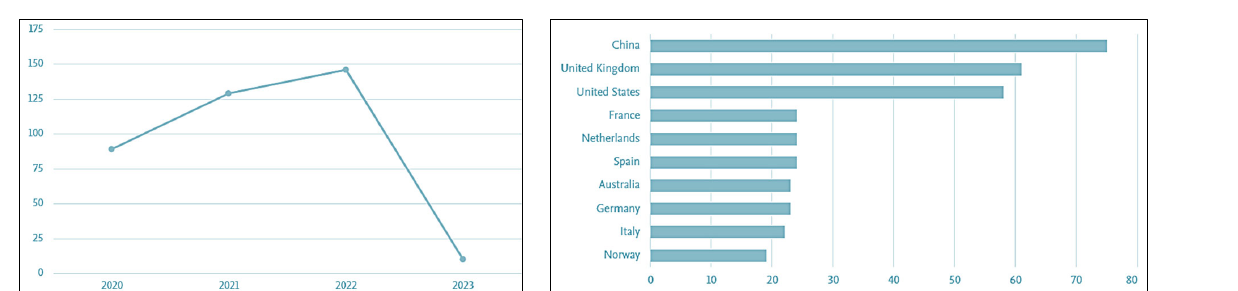
Fig. 5. The growth of the publication based on the variables “Clean energy” and “Sea Water”.